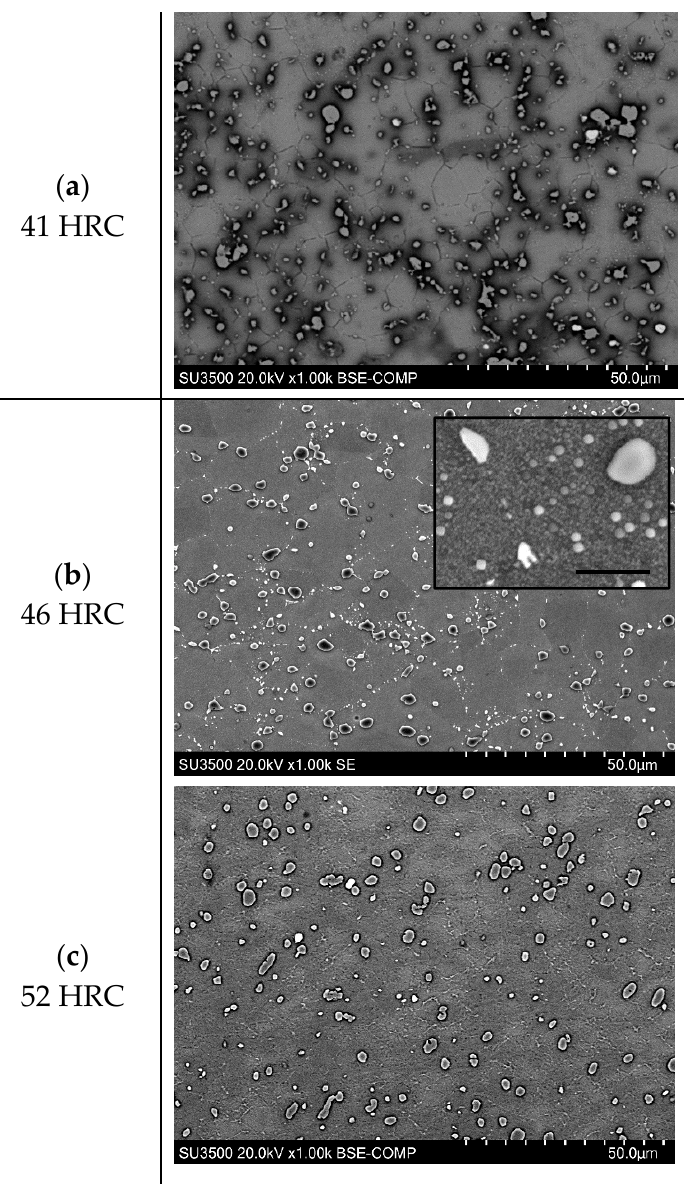
Figure 9. Rene 65 Microstructure at: ( a ). 41 HRC ( b ) 46 HRC ( c ) 52 HRC.